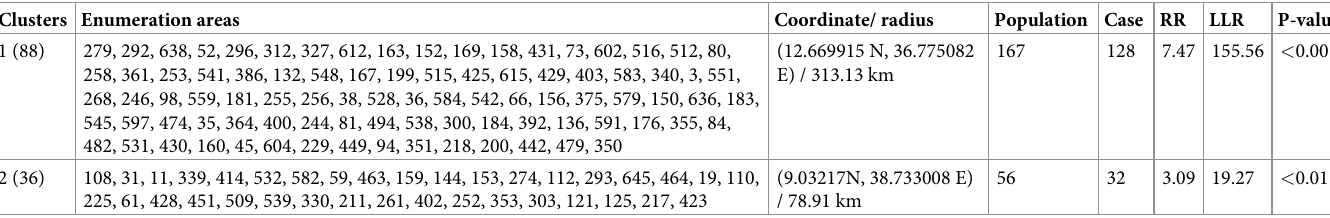
Table 2. SaTScan analysis result of alcohol consumption among pregnant women in Ethiopia, 2016. Clusters Enumeration areas Coordinate/ radius Population Case RR LLR